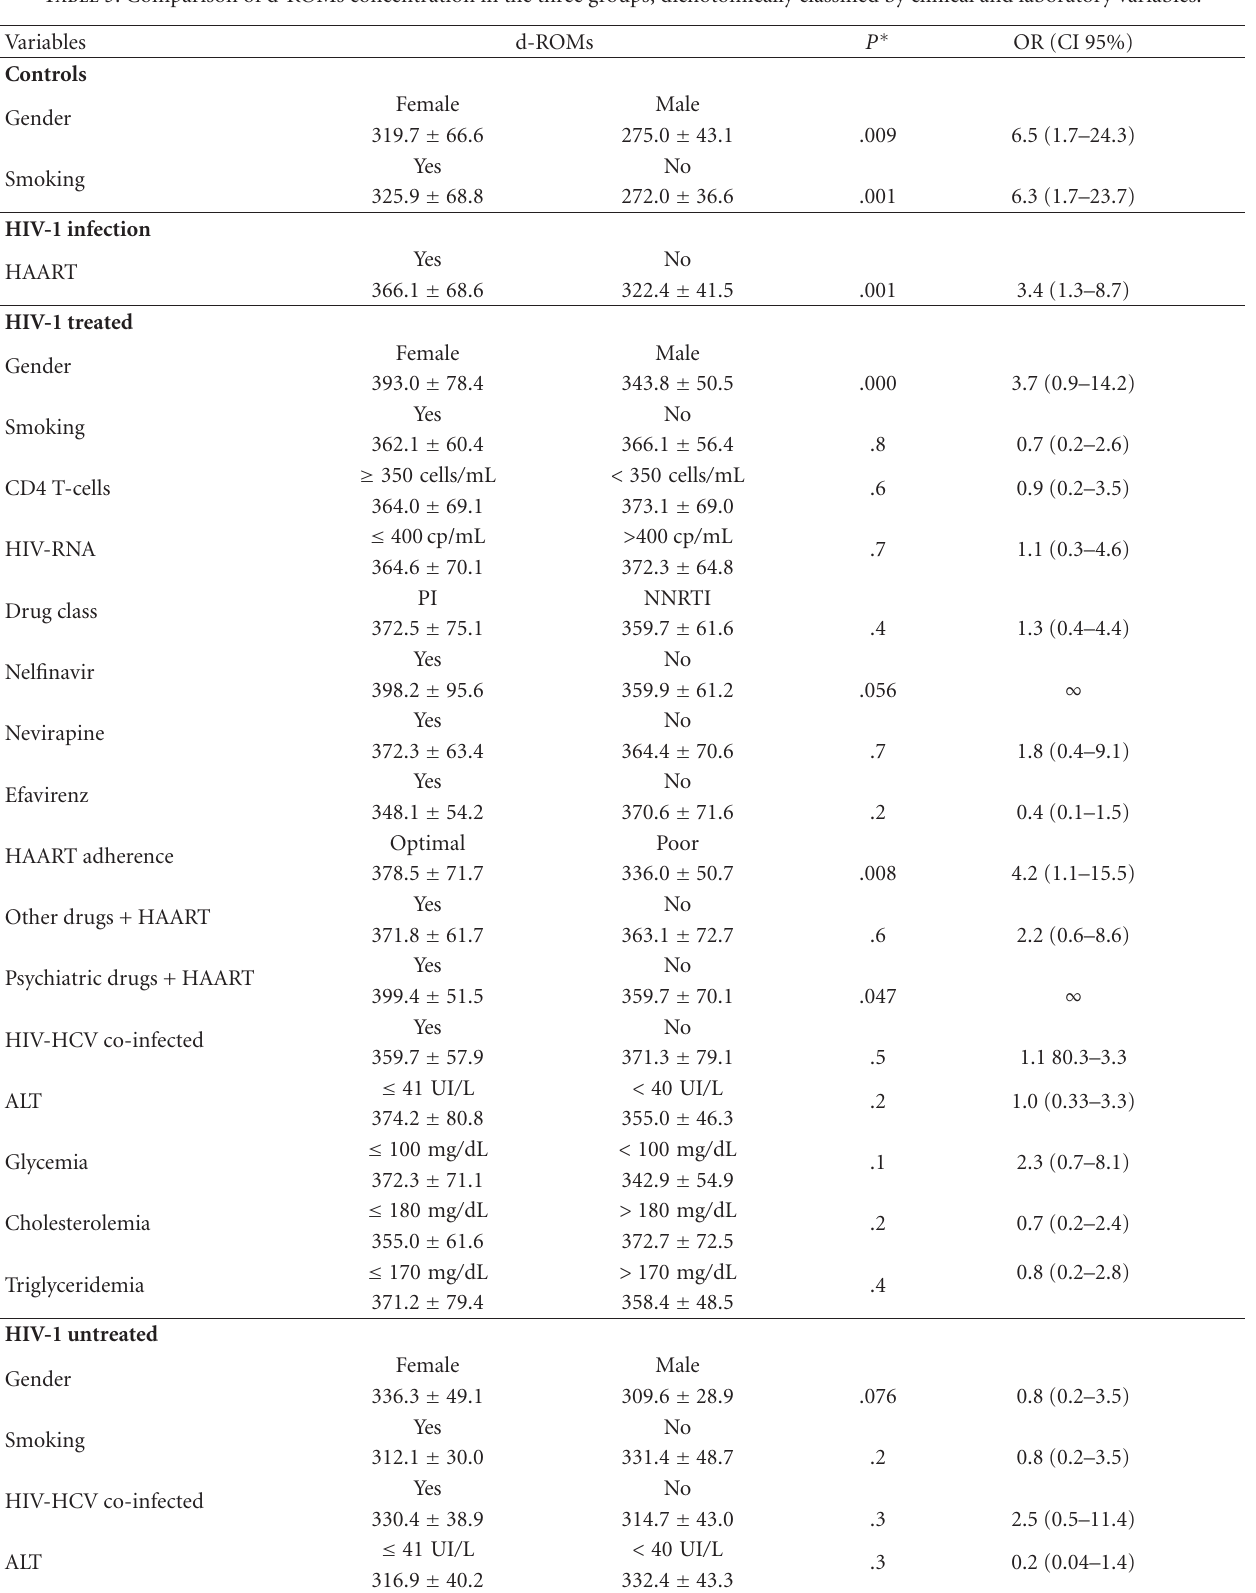
Table 3: Comparison of d-ROMs concentration in the three groups, dichotomically classified by clinical and laboratory variables.